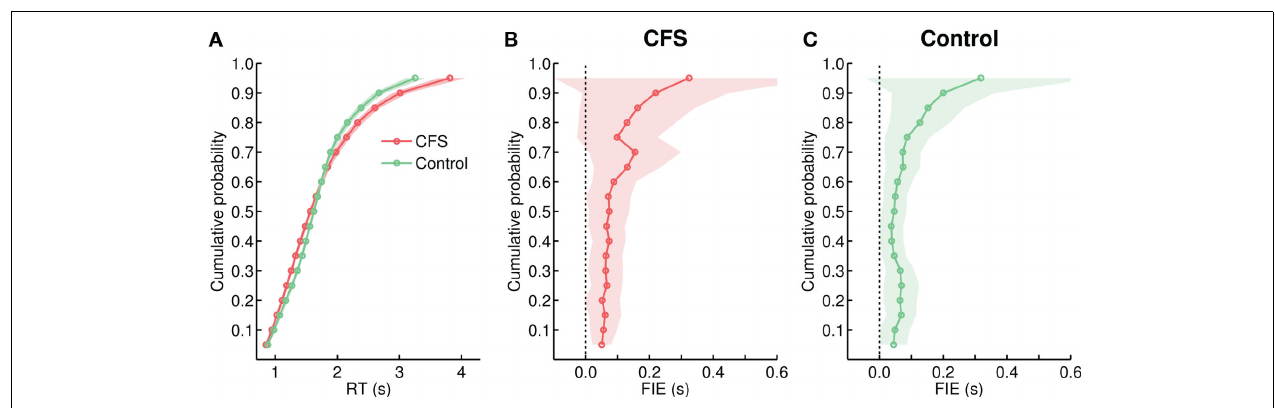
FIGURE 6 | (A) Cumulative group distributions of RTs from the CFS and from the control condition in Experiment 2. (B,C) Size of the FIE as a function of percentiles, plotted separately for the CFS and the control condition.